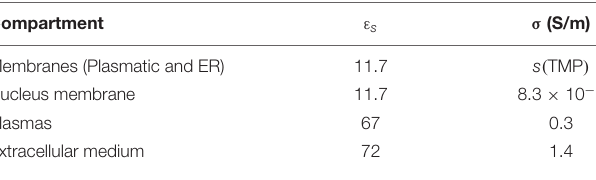
TABLE 1 | Electrical permittivity and conductivity of the cell compartments (Denzi et al., 2016).